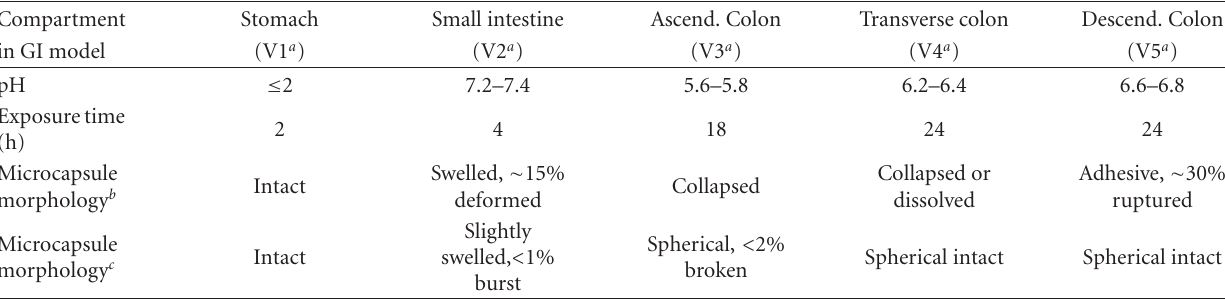
Table 1: Exposure of microcapsules to the simulated human GI transit (72 h in total) and the corresponding morphological changes. Compartment